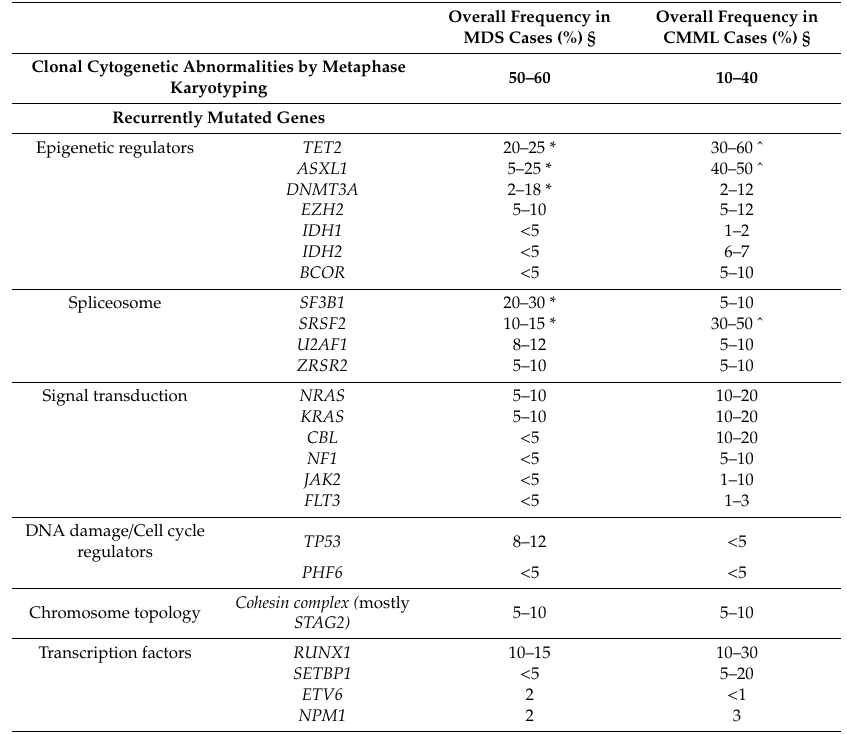
Table 4. Overall incidence of cytogenetic / molecular lesions in MDS and CMML patients at